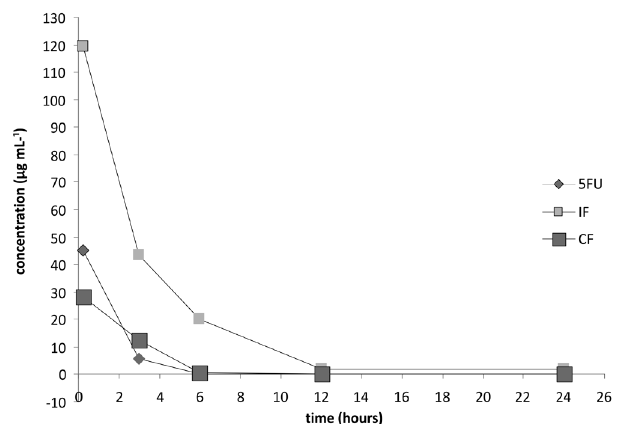
FIGURE 4 - Kinetic curve of antineoplastic drugs 5-fluorouracil (-5-FU), ifosfamide (IF) and cyclophosphamide (CP), obtained after a single intravenous infusion in